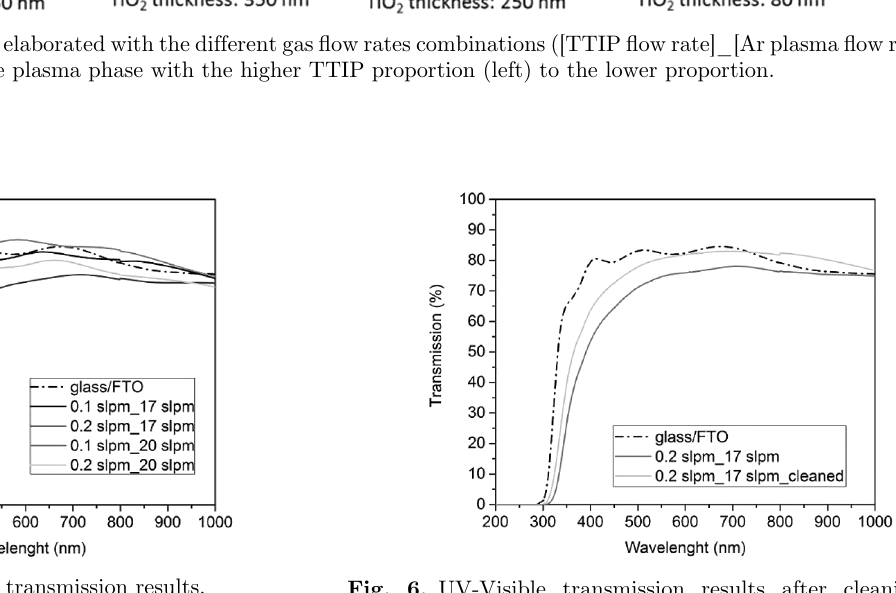
Fig. 5. UV-Visible transmission results. Fig. 6. UV-Visible transmission results after cleaning the 0.2 slpm_17 slpm titania fi